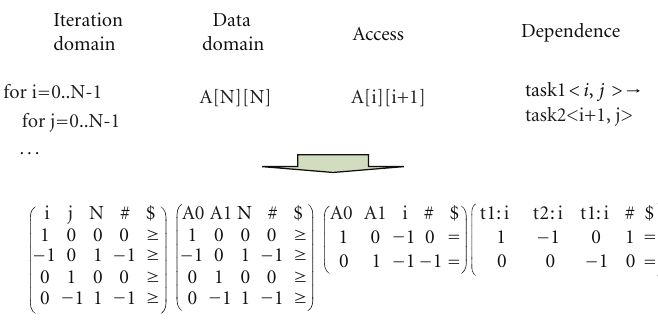
Figure 4: Polyhedral matrix